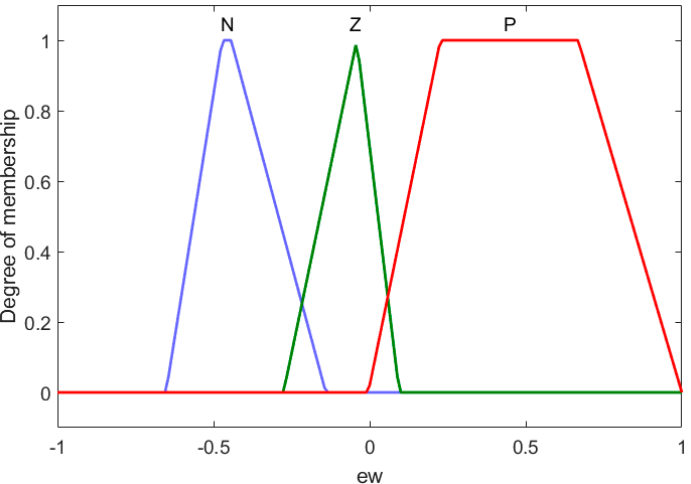
Figure 14. Membership functions for Input 2.